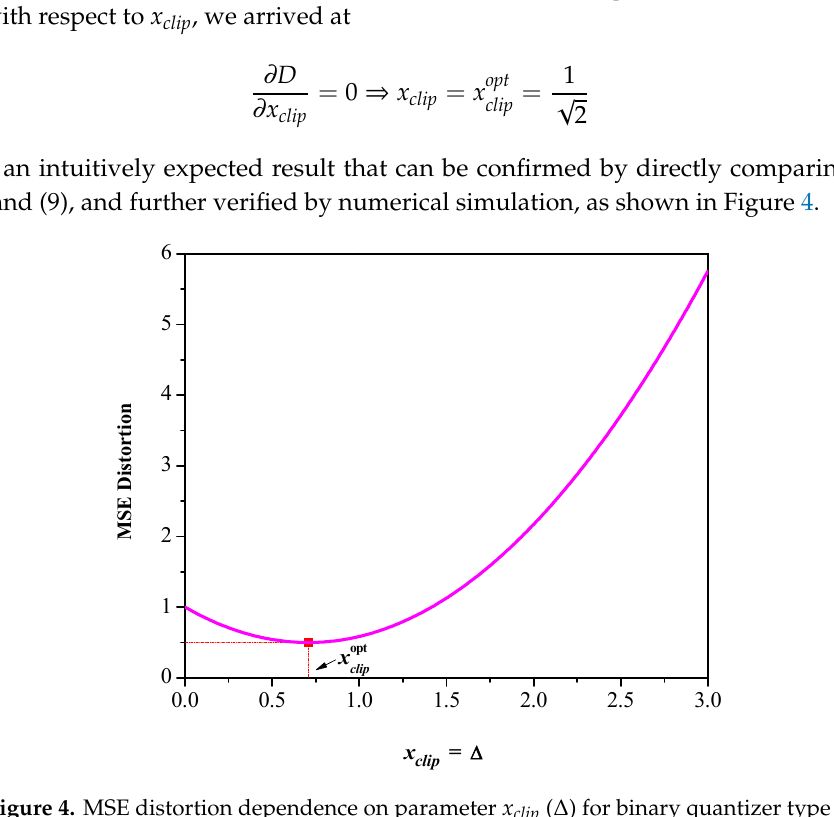
Figure 4. MSE distortion dependence on parameter x clip (Δ) for binary quantizer type 2.